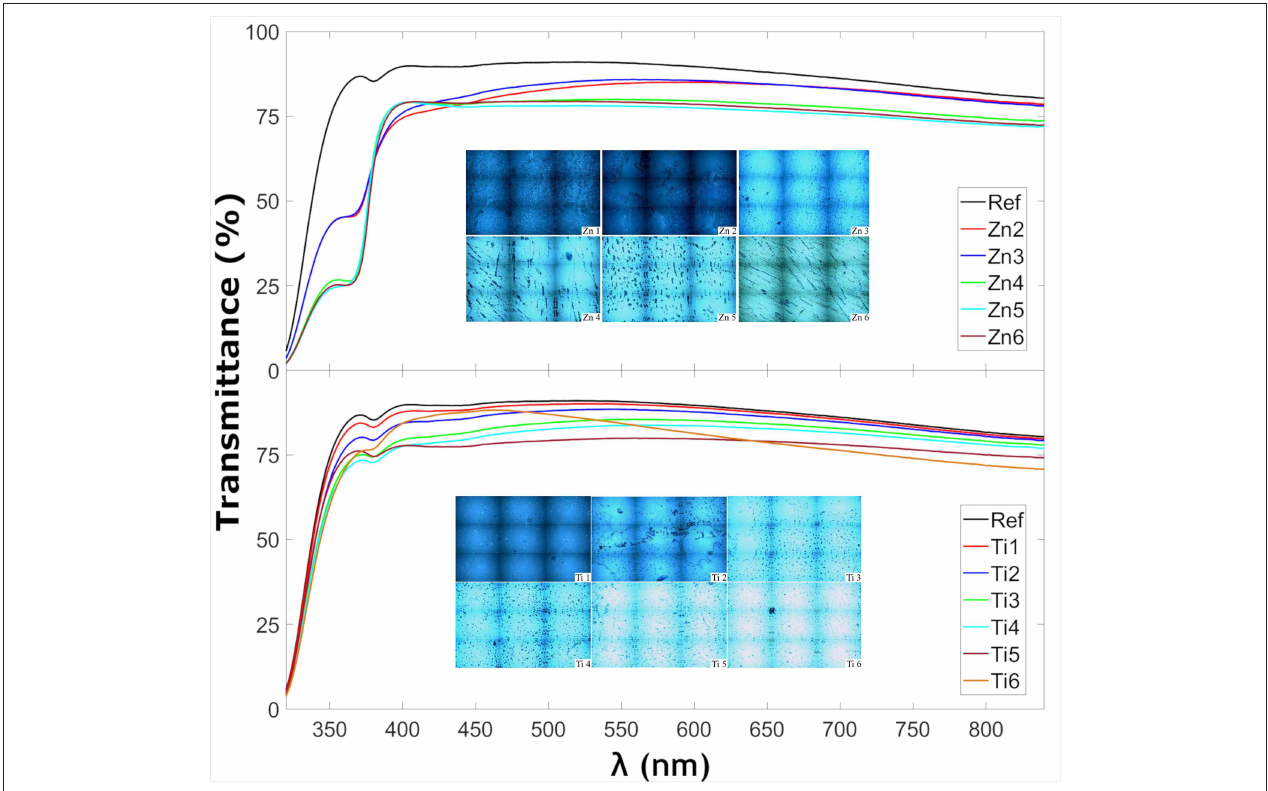
FIGURE 1 | Transmittance of thin film-coated glass samples at normal incidence as well as insets of microscope images of the samples taken from the Raman microscope.